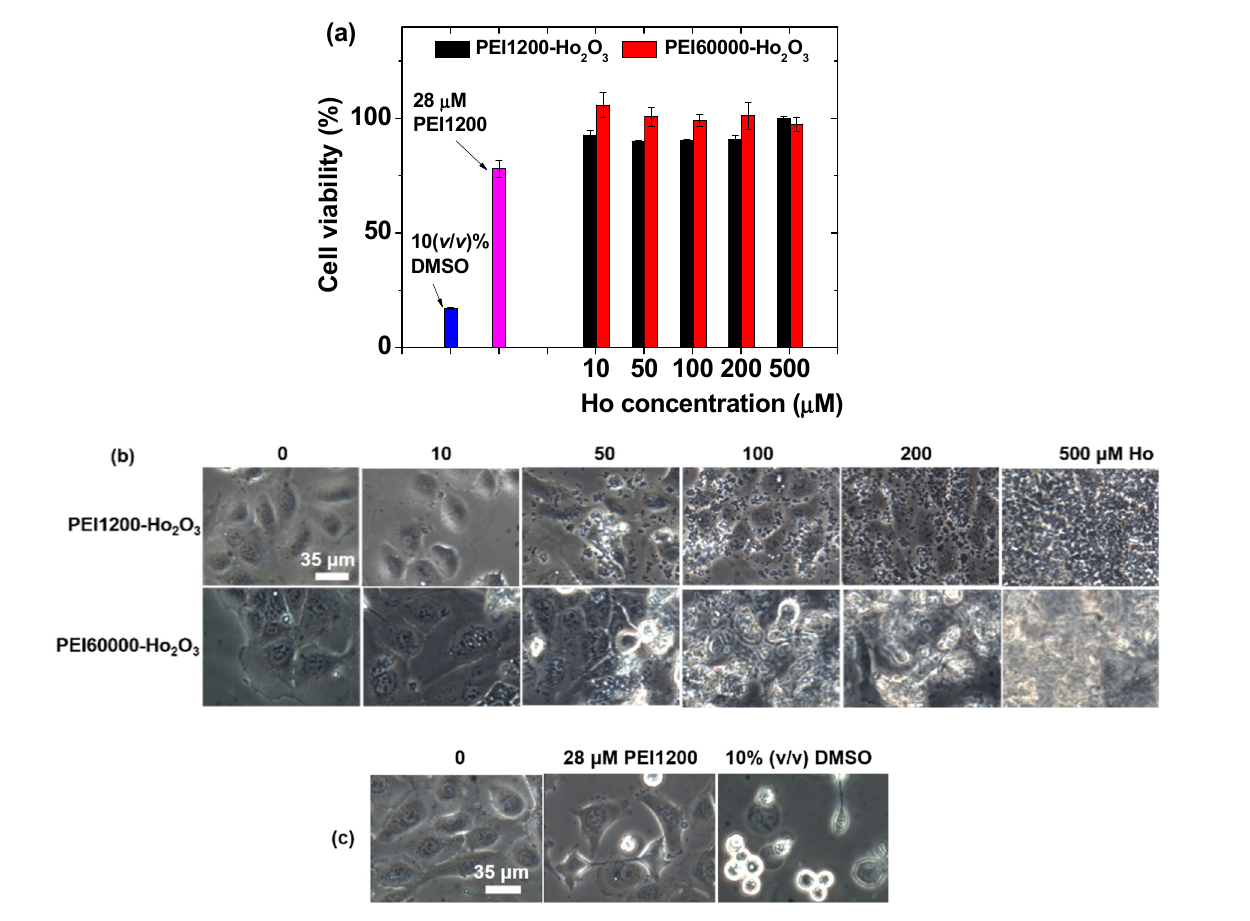
Figure 6. ( a ) In vitro cell viabilities after normalization with untreated control cells (0.0 mM Ho). 10% ( v / v ) DMSO was used as a positive control. ( b ) Optical microscopy images of the DU145 cells 48 h after incubation with PEI1200- and PEI60000-coated ultrasmall Ho 2 O 3 nanoparticles. ( c ) Optical microscopy images of the DU145 cells 48 h after incubation with 10% ( v / v ) DMSO and 28 µ M PEI1200.